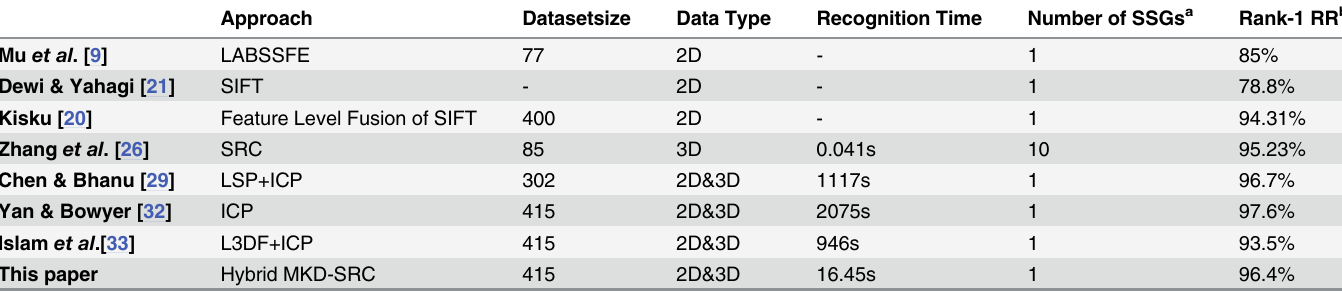
Table 3. Performance